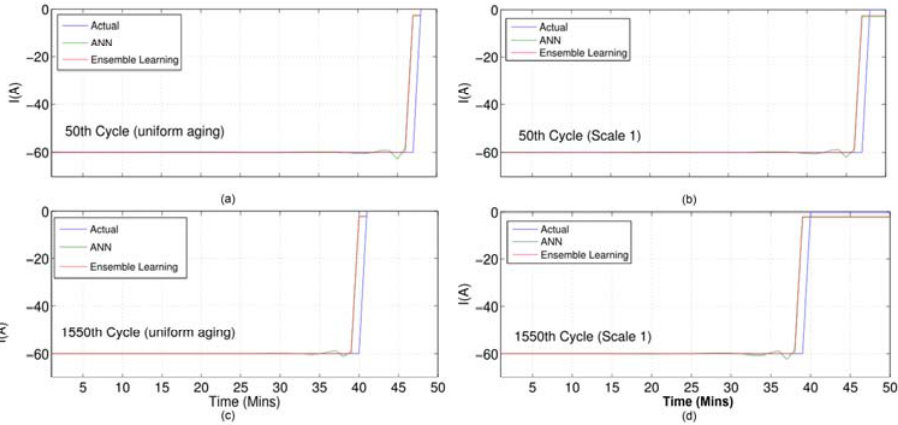
Figure 13. Discharging profiles predictions for uniform aging and non-uniform aging with Scale 1. ( a ) 50th Cycle; ( b ) 550th Cycle; ( c ) 1050th Cycle; ( d ) 1550th Cycle.